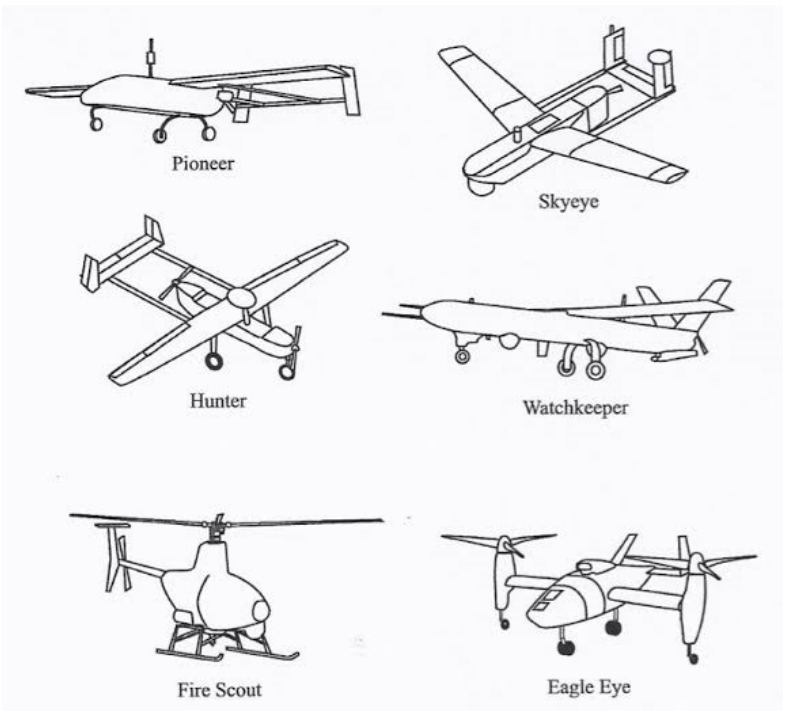
Figure 3. Application-specific drone